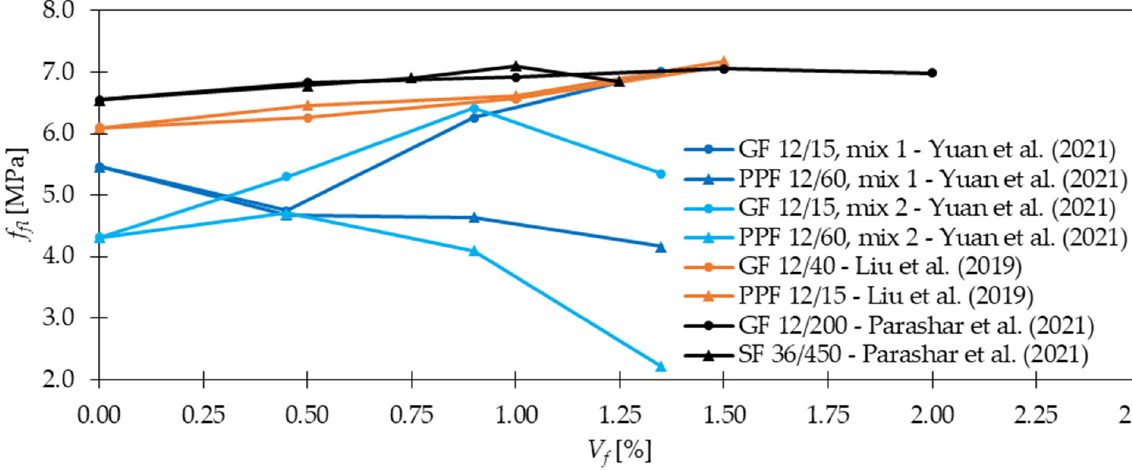
Figure 13. Influence of V f on f fl for different fiber material and geometry l f /d f [23,26,53].